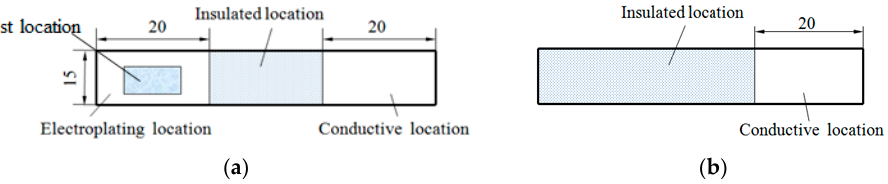
Figure 1. Schematic diagram of the matrix size of the substrate and the sealing, plating, and conductive locations: ( a ) front view and ( b ) back-face view.